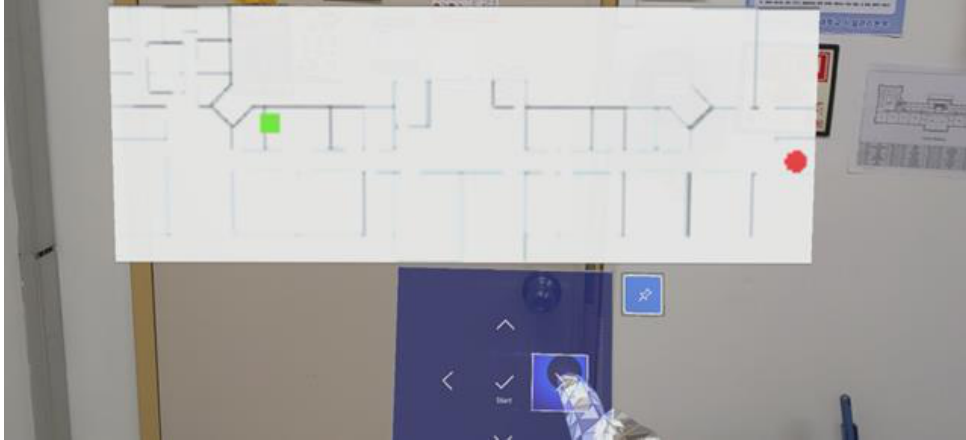
indicates the user’s location, and the green box indicates the destination. The destination generates a path to the selected destination.